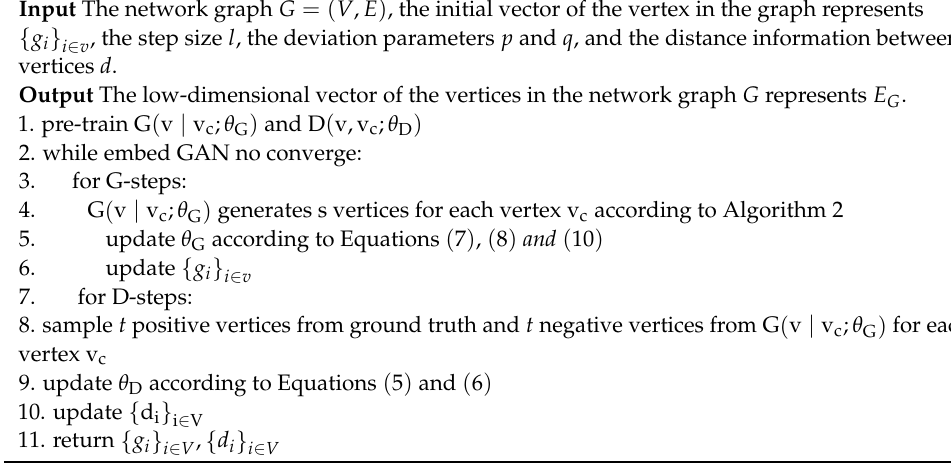
Algorithm 3: EmbedGAN Algorithm